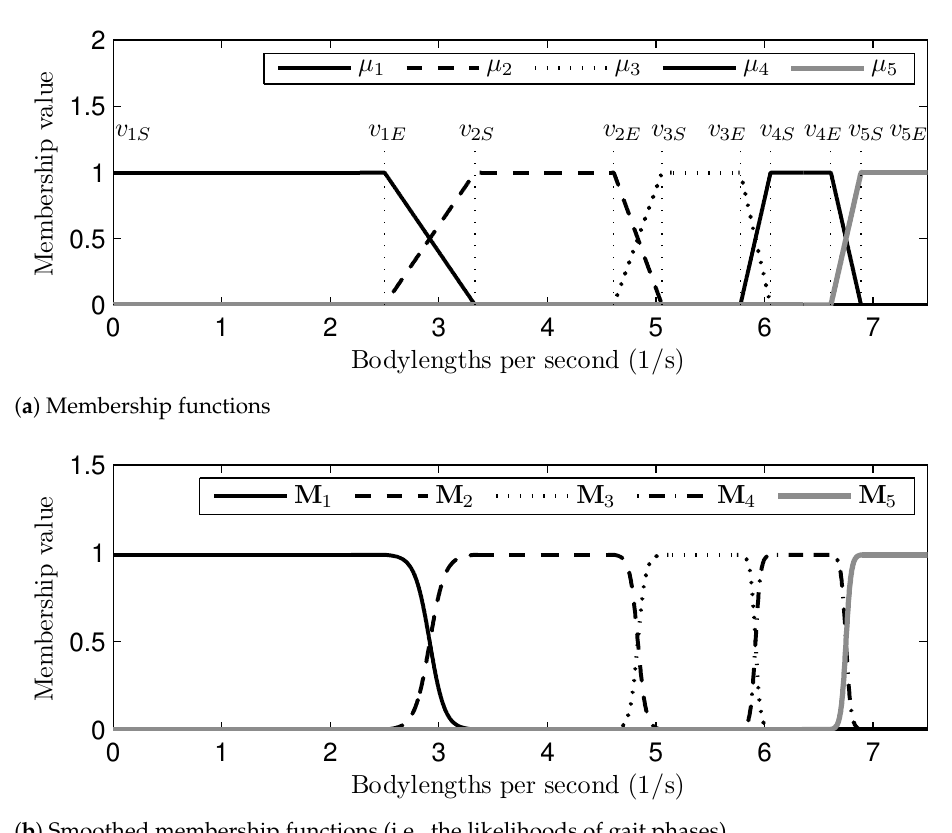
Figure 7. Transition of gait phases by fuzzy logic: ( a ) membership functions and ( b ) smoothed membership functions (i.e., the likelihoods of gait